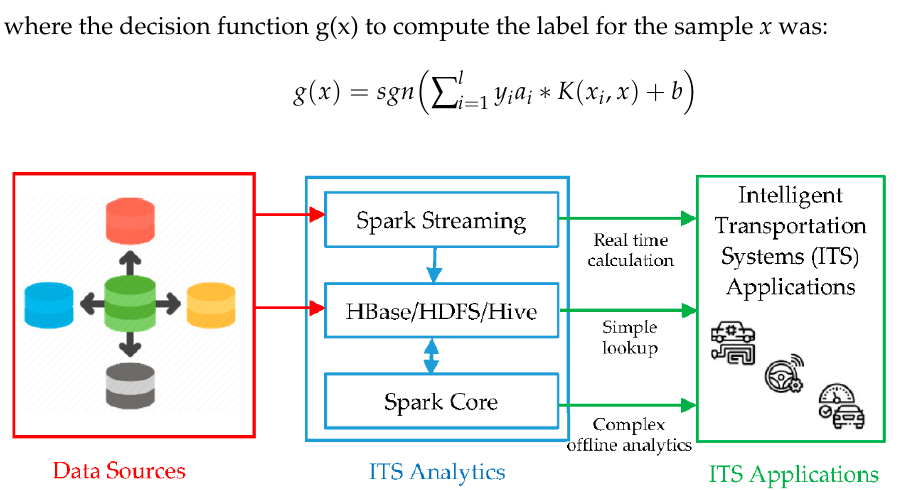
Figure 4. The use of big data platforms in ITS applications, modified based on [29].